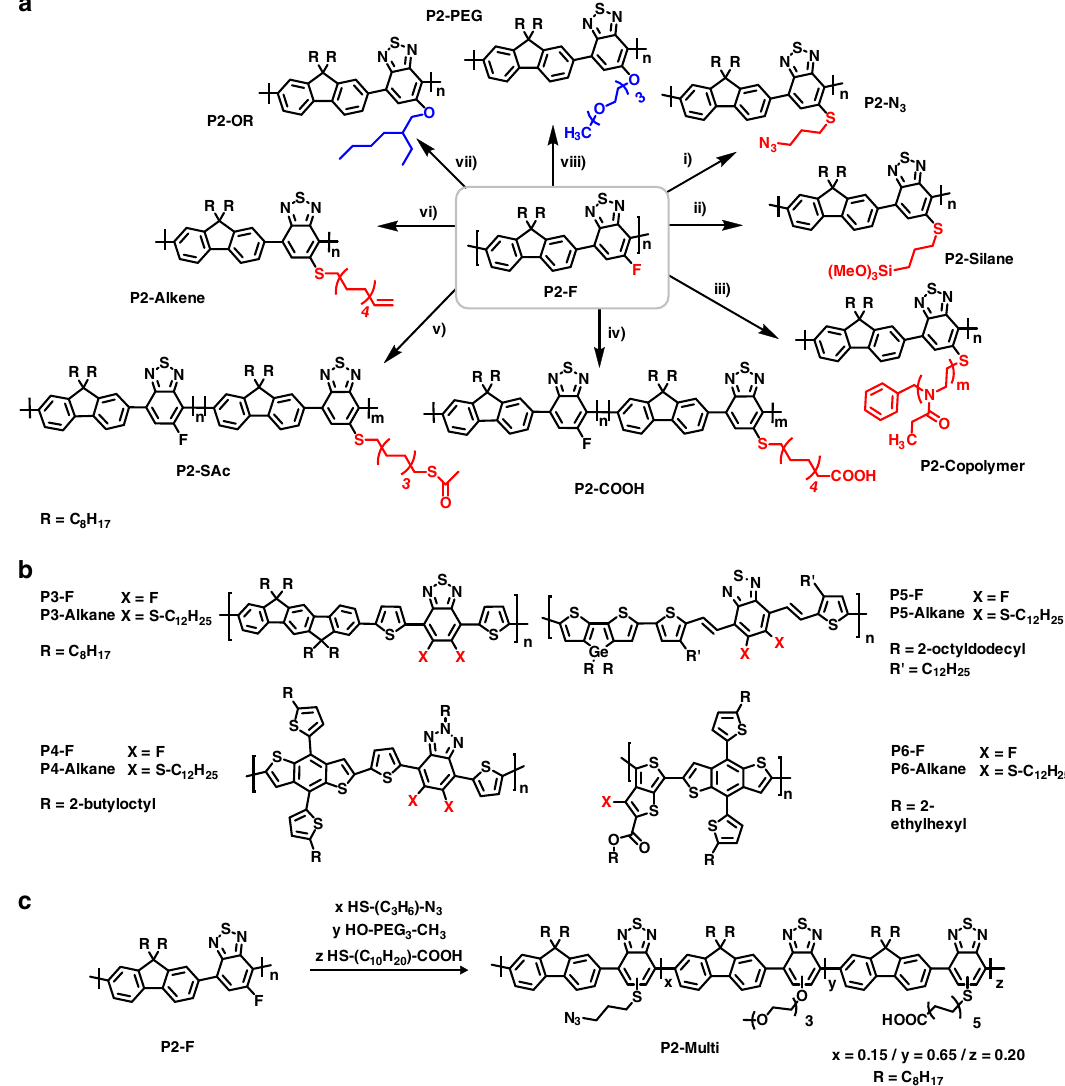
Fig. 3 Scope of the reaction. a Reaction of P2-F with functionalised thiols, thioacetates and alcohols: all reactions in CB:DMF (3:1, v-v) solvent. (i) S -(3- azidopropyl)thioacetate, KOH; (ii) (3-mercaptopropyl)trimethoxysilane, K 2 CO 3 ; (iii) poly(2-ethyl-2-oxazoline), K 2 CO 3 ; (iv) 11-mercaptoundecanoic acid, K 2 CO 3 ; (v) 1,8-octanedithiol diacetate, NaOH; (vi) S -(10-undecenyl)thioacetate, KOH; (vii) 2-ethyl-1-hexanol, KOH; (viii) triethylene glycol monomethyl ether, KOH. b Structures of polymers P3 – P6 before and after thiol substitution. c Schematic of the synthesis of the multifunctionalised polymer ( P7-Multi